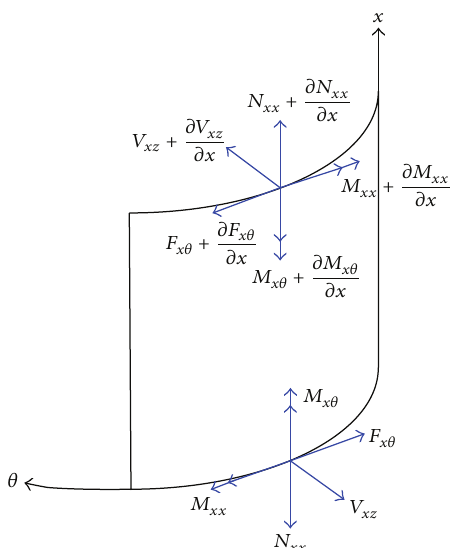
Figure 2: Force and moment resultants in a circular cylindrical shell.